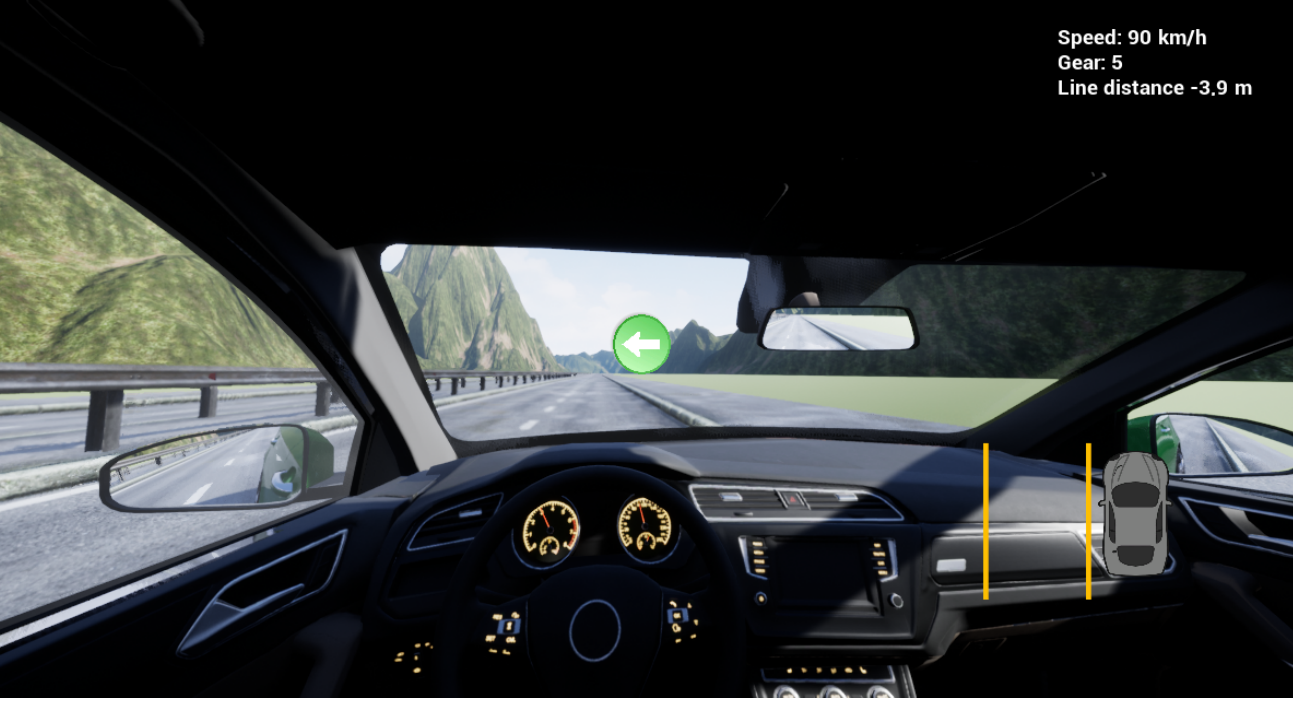
Figure 5. VDS—First person camera